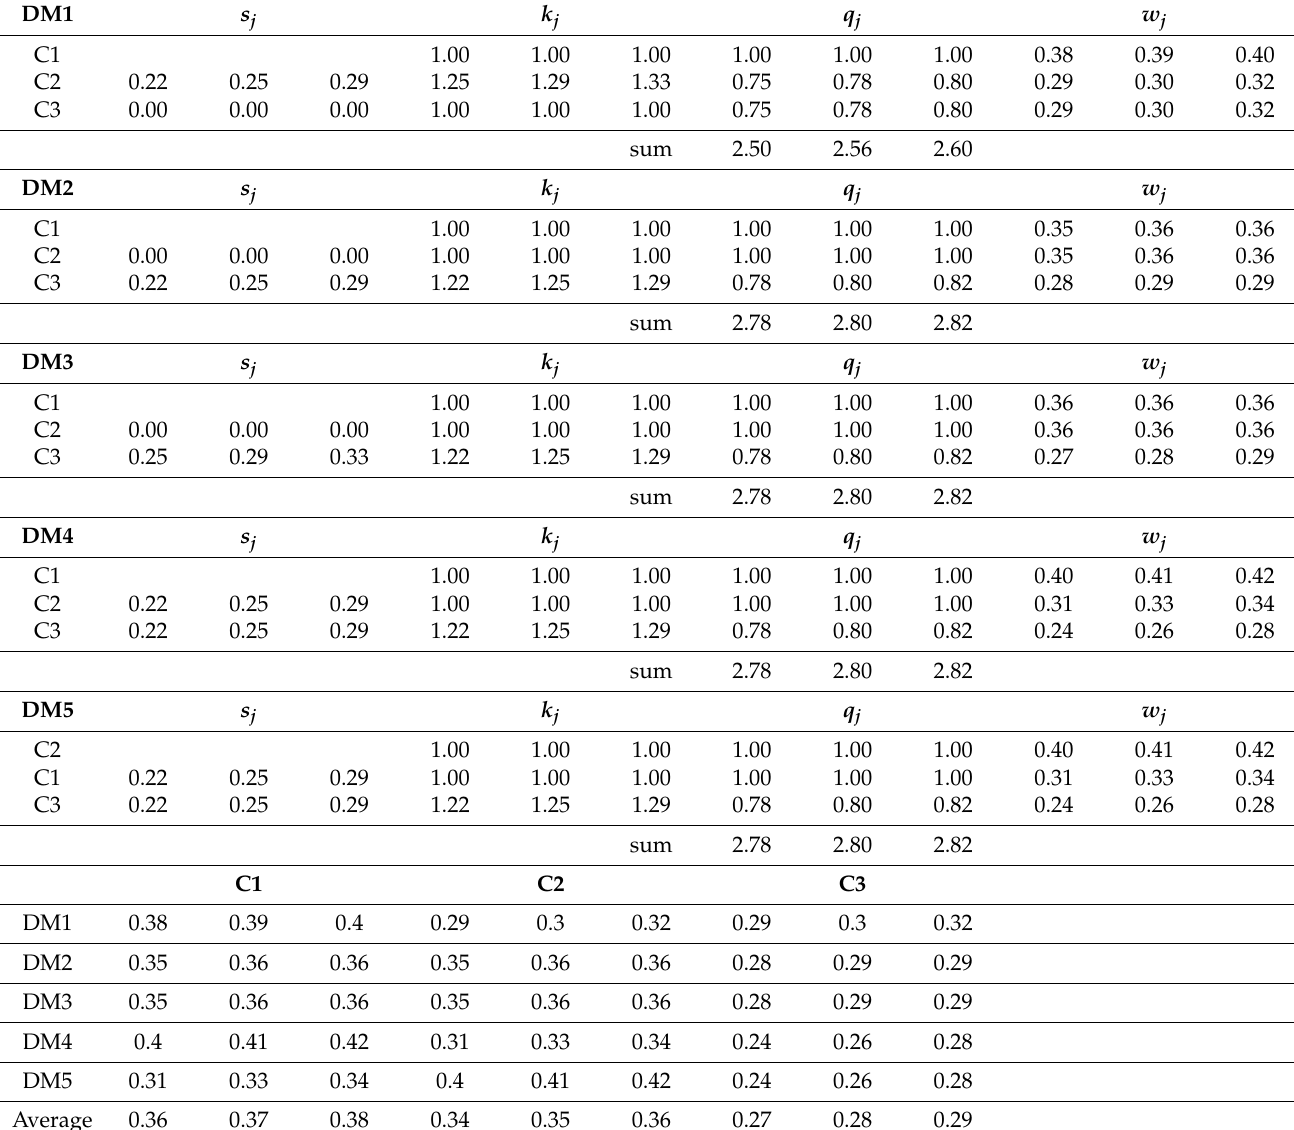
Table 5. Weights of the main